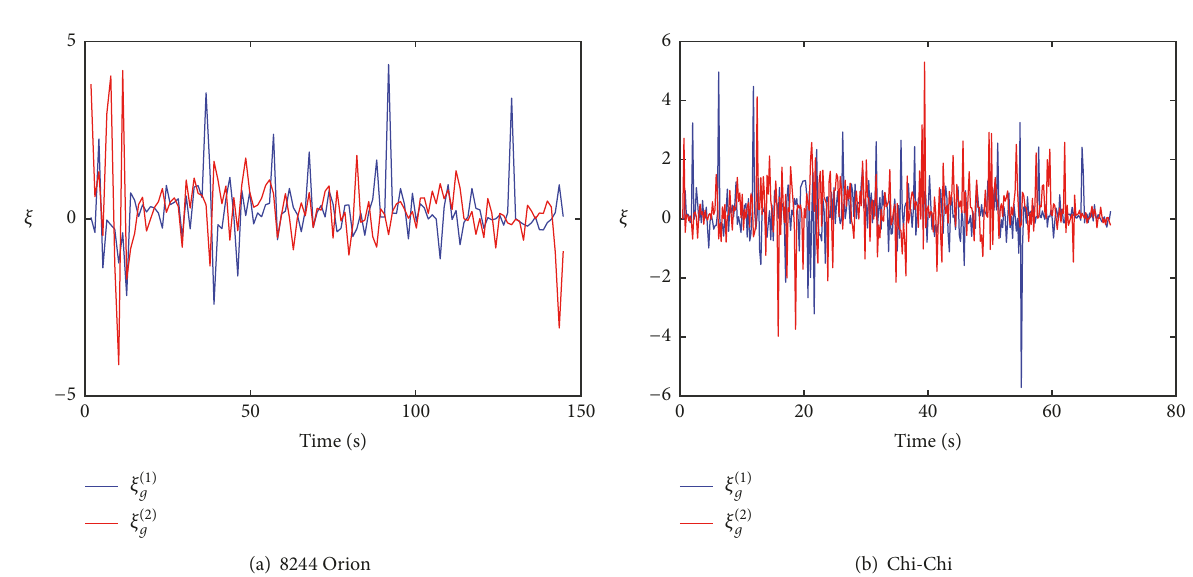
Figure 4: Identified values of {𝜉 (1) 𝑔 (𝑡 𝑖 ),𝜉 (2) 𝑔 (𝑡 𝑖 )} for the 8244 Orion and Chi-Chi